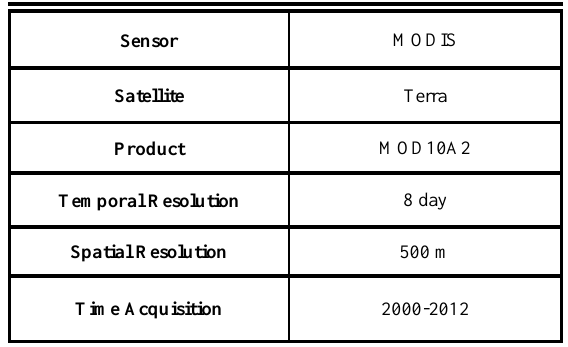
Table 1: Information of MODIS data